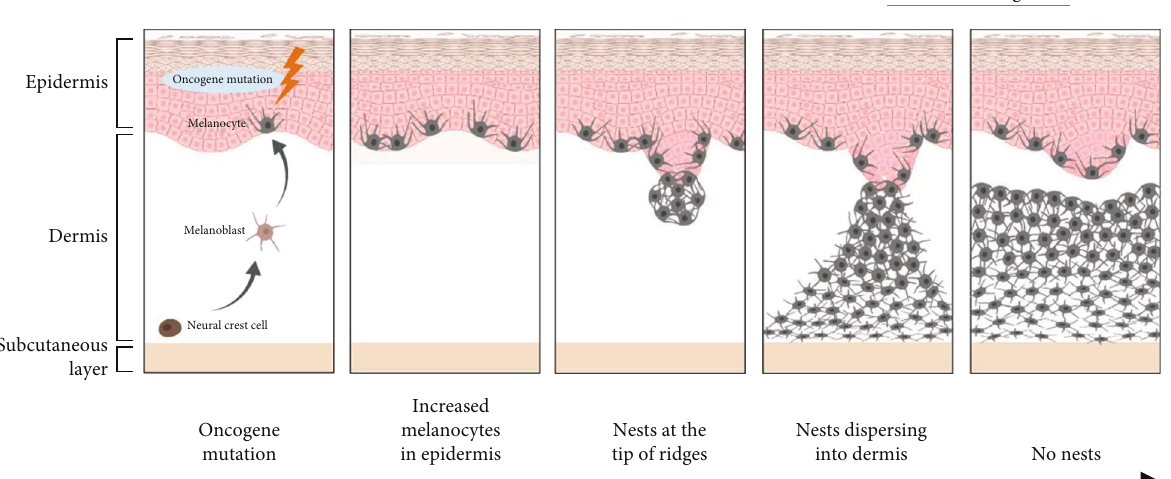
Figure 6: Schematic illustration of nevogenesis (created with BioRender). The mutated melanocyte fi rst colonizes and proliferates along the basal layer of the epidermis, after which some of the nevocytes proliferate and form nests composed of aggregated nevocytes. As the nest grows, it gradually penetrates and disperses the dermis, forming a high density of round-shaped nevocytes in the super fi cial dermis and a low density of spindle-shaped nevocytes in the deep